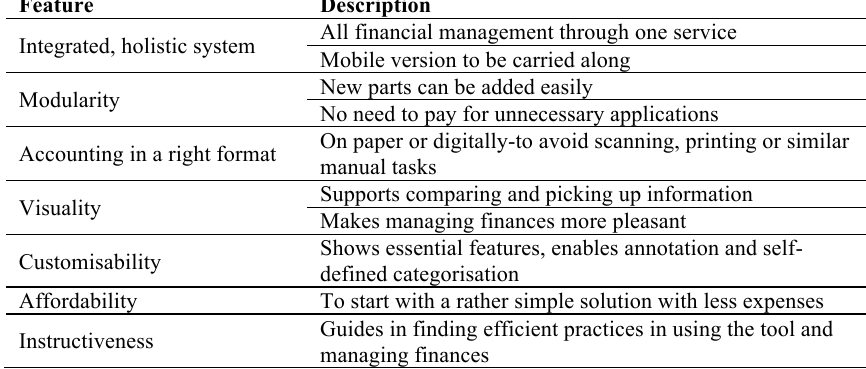
Table 2 . Desired features for small business owners’ finance